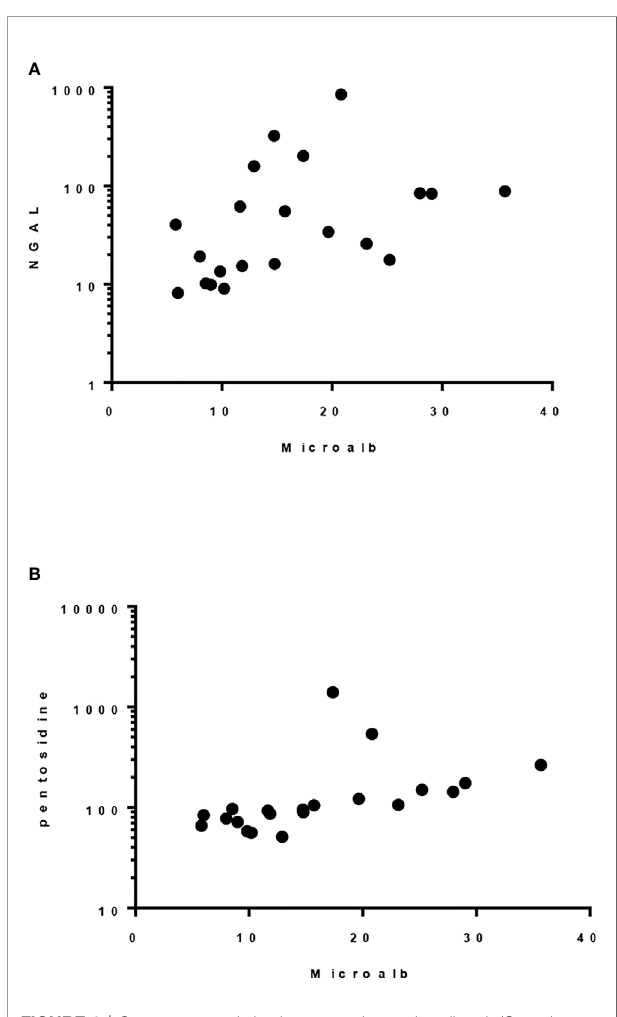
FIGURE 1 | Spearman correlation between urinary microalbumin/Cr and: (A) uNGAL/Cr, r = 0.5662, p 0.0075 and (B) Pentosidine/Cr. r = 0.787, p <